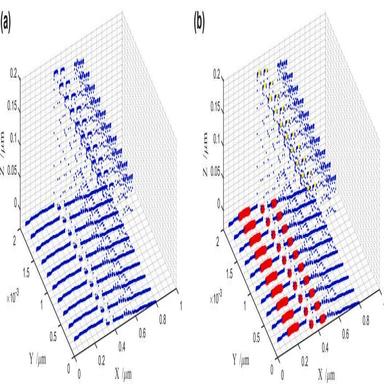
Visualization of the measurement data by surface profiler: (a) The raw data; (b) The evaluation area in red and yellow; (c) The extracted upper planes and lower plane for step height characterization. (For interpretation of the references to color in this figure legend, the reader is referred to the Web version of this article.)